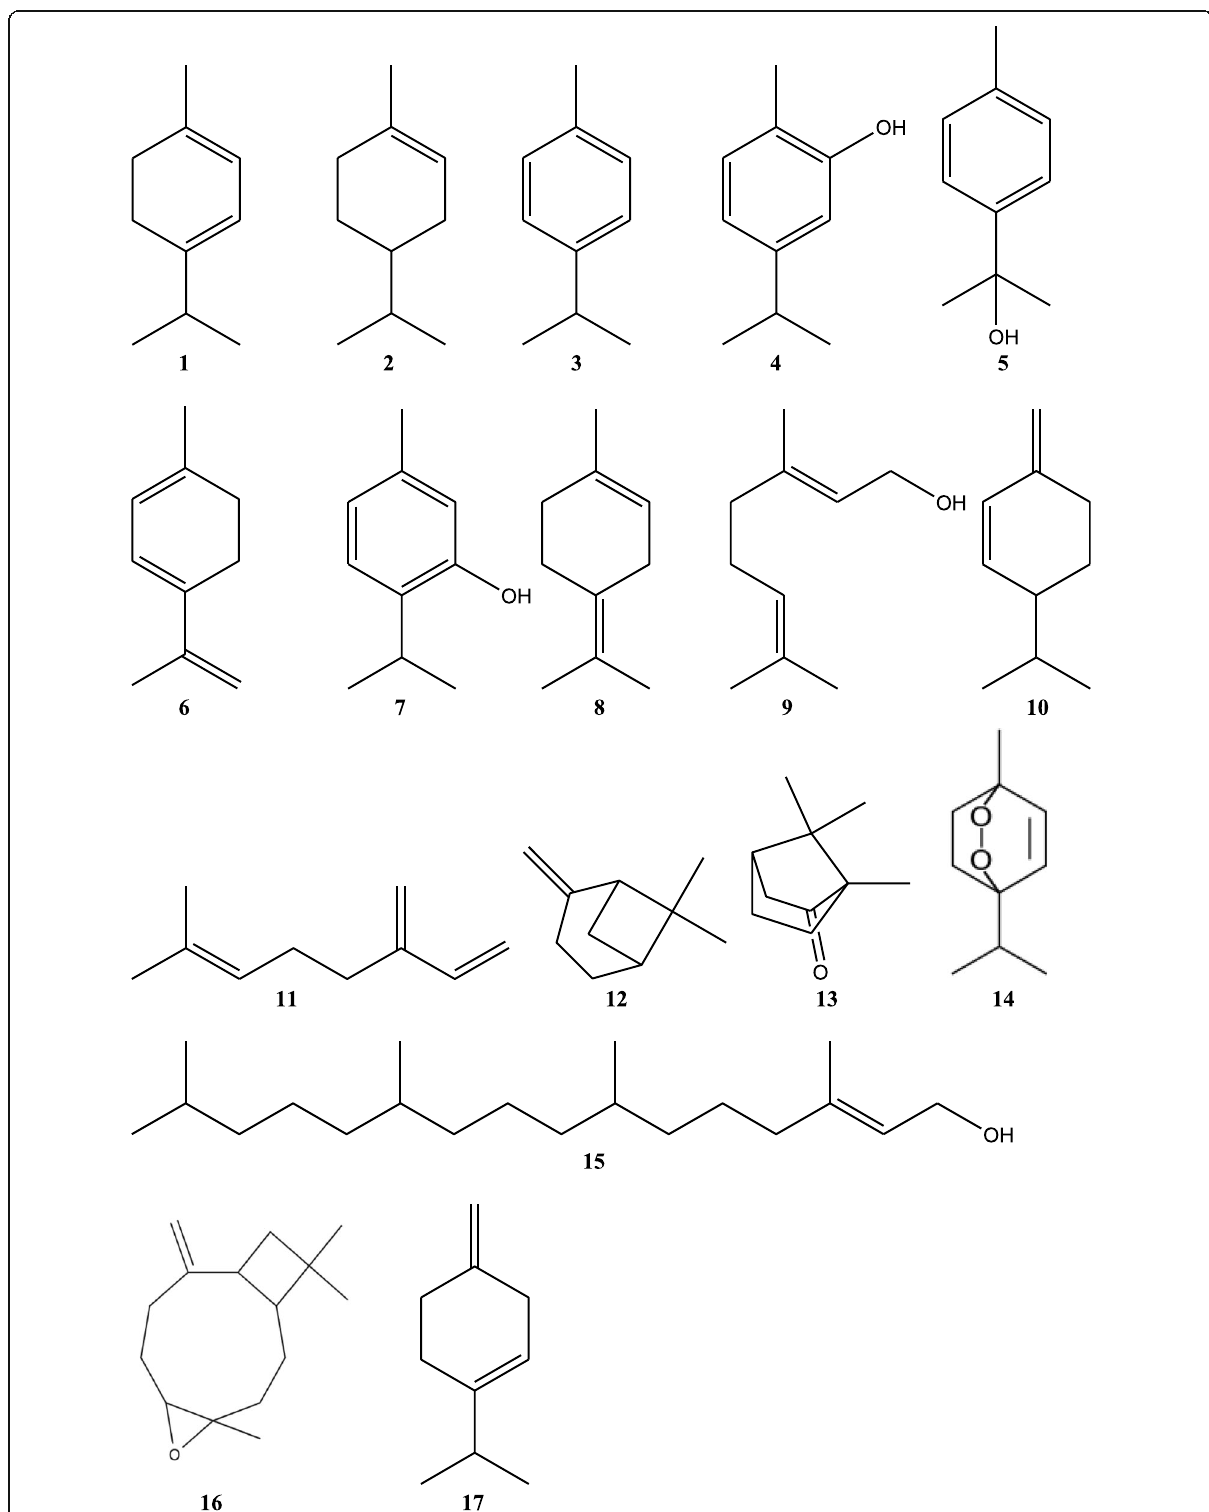
Fig. 3 Structures of a few significant compounds from C. ambrosioides (Draw using ChemDraw Ultra 8.0